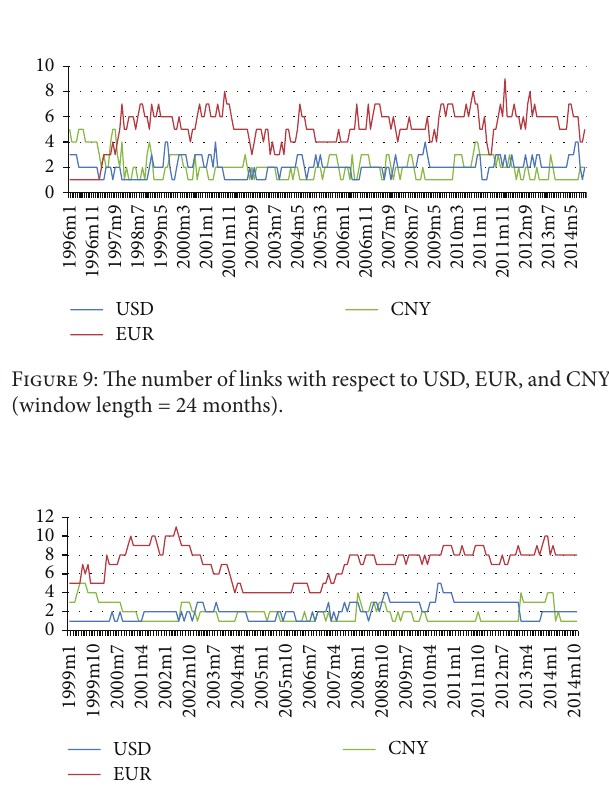
Figure 8: The number of links with respect to USD, EUR, and CNY (window length = 12 months).